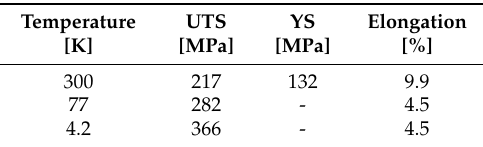
Table 3. Tensile properties of AZ31B magnesium alloy [18].